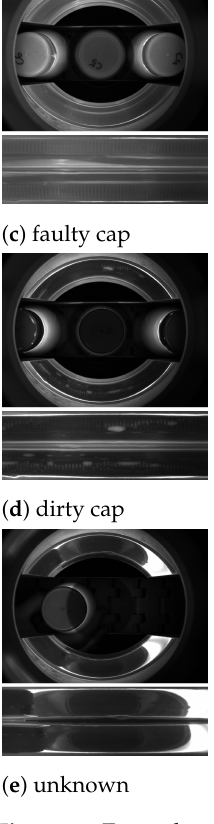
Figure 2. Example original images acquired with Inspect360+ and corresponding images after calibration procedure for each